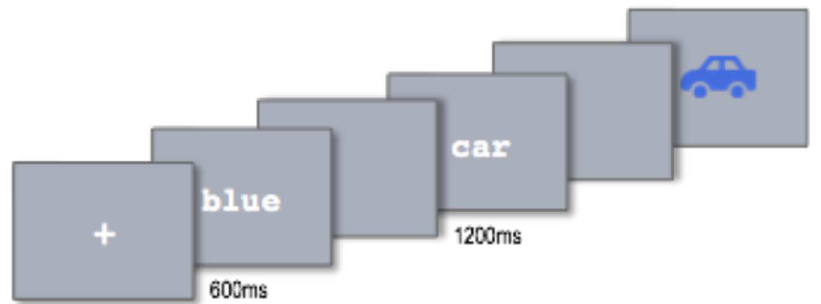
Fig 1. Illustration of the stimulus presentation sequence in a single trial. Each trial began with a fixation cross, followedby 300 ms of blank screen, 300 ms of word 1, 300 ms of blank screen, 300 ms of word 2, 300 ms of blank screen, and the